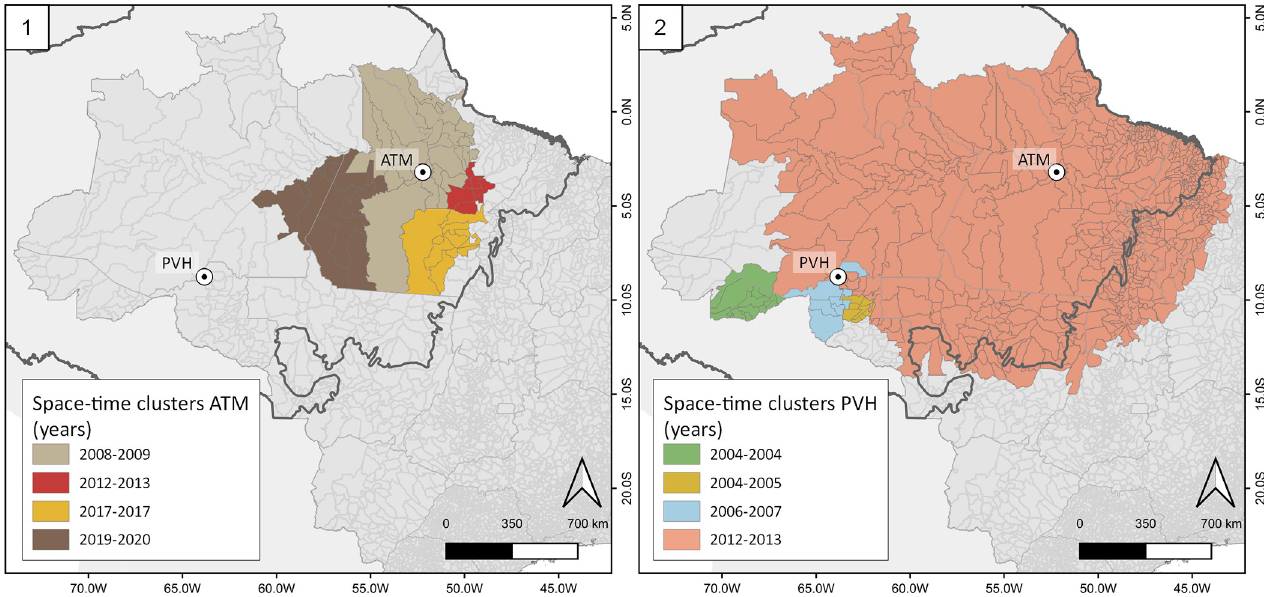
Fig 4. Space-time clusters of malaria exported cases from the study areas. 1. Clusters of malaria exported cases from Altamira region (ATM), by year, for the period 2007 to 2020. 2. Clusters of malaria exported cases from Porto Velho municipality (PVH), by year, for the period 2004 to 2017. The thick grey line represents the Amazon basin. The spatial units are Brazilian municipalities, represented as light gray areas. Arrows indicate solely the direction of the malaria cases flow, from the sources (ATM and PVH) to the sinks (other areas in the country). Figure created with QGIS software version 3.14, an open source Geographic Information System (GIS) licensed under the GNU General Public License (https://bit.ly/2BSPB2F). Base layer sources: South America shape file retrieved from the Database of Global Administrative Areas (GADM) website (https://bit.ly/3ZqwJ4u), under an open license (CC-BY): http://bit.ly/3Zl2rjE; shape file representing the Brazilian administrative areas provided from the Brazilian Institute of Geography and Statistics (IBGE) website (https://bit.ly/ 3vWaZjC), under an open license (CC-BY): https://bit.ly/3W2qxNk.